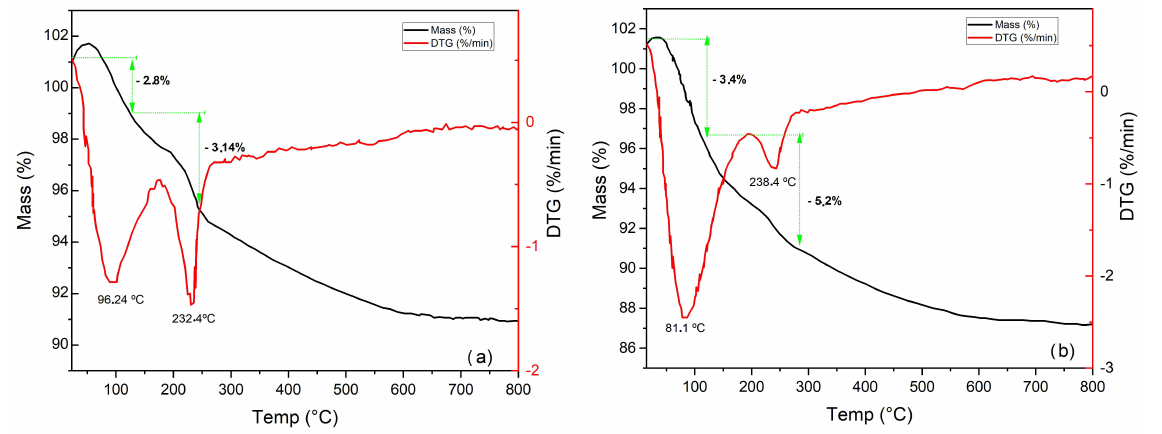
Figure 5. Thermogravimetric curves of synthesized clays ( a ) NAS and ( b )